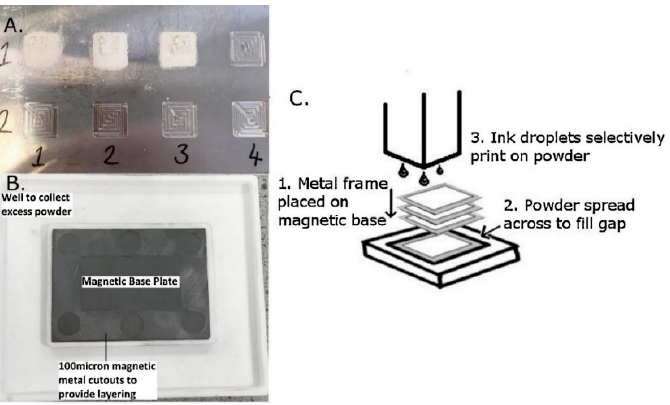
Figure 27. ( A ) A 2D recessed plate for testing powder and ink interactions; ( B ) a 3D powder stacking process; ( C ) an experimental graphic of a 3D layering system in use with processes 1, 2, and 3 cycled until finished (adapted with permission from reference [68]).